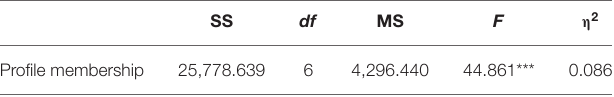
TABLE 6 | ANCOVA results comparing problematic game usage among